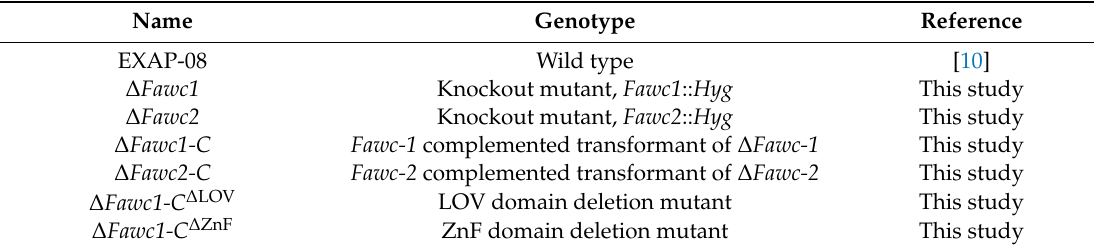
Table 1. F. asiaticum strains used in this study. LOV: Light–oxygen–voltage, ZnF: Zinc